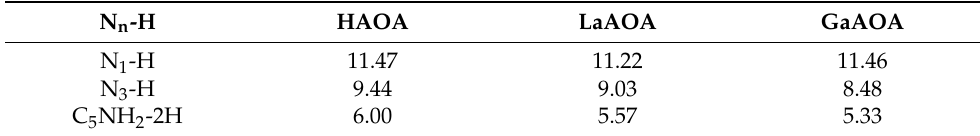
Table 2. 1 H NMR (250 MHz, DMSO- d 6